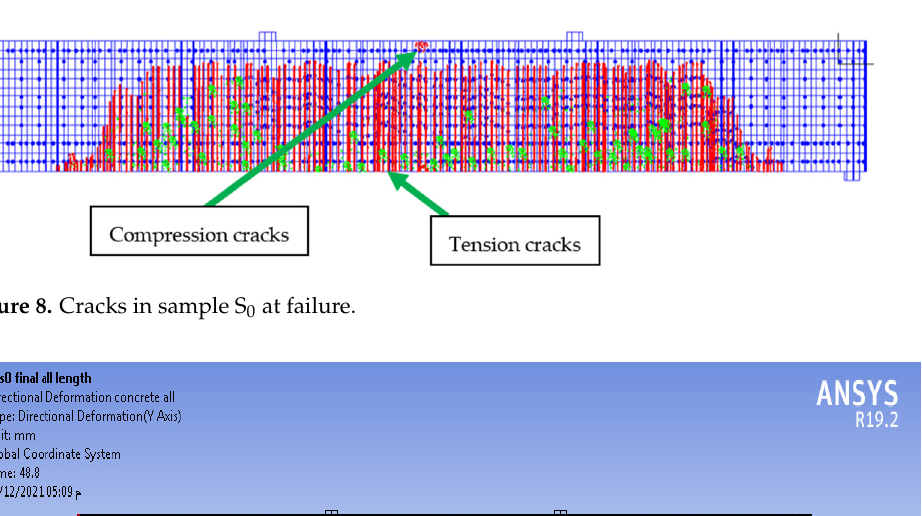
Figure 7. Initial crack of sample S 0 .